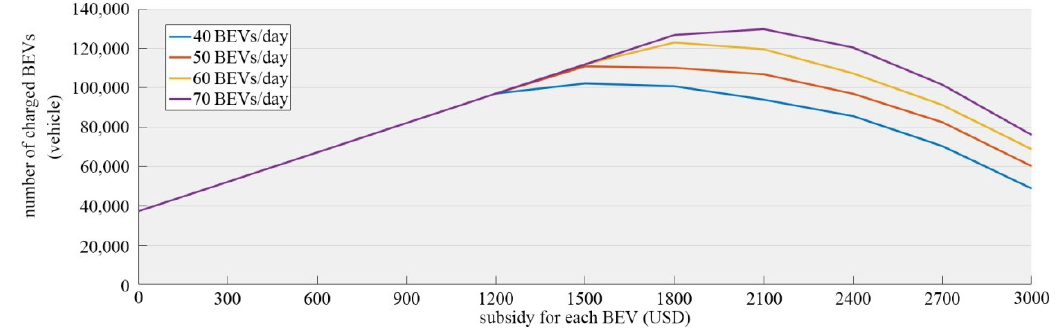
Figure 10. The results under different capacities of the charging pile and subsidies.